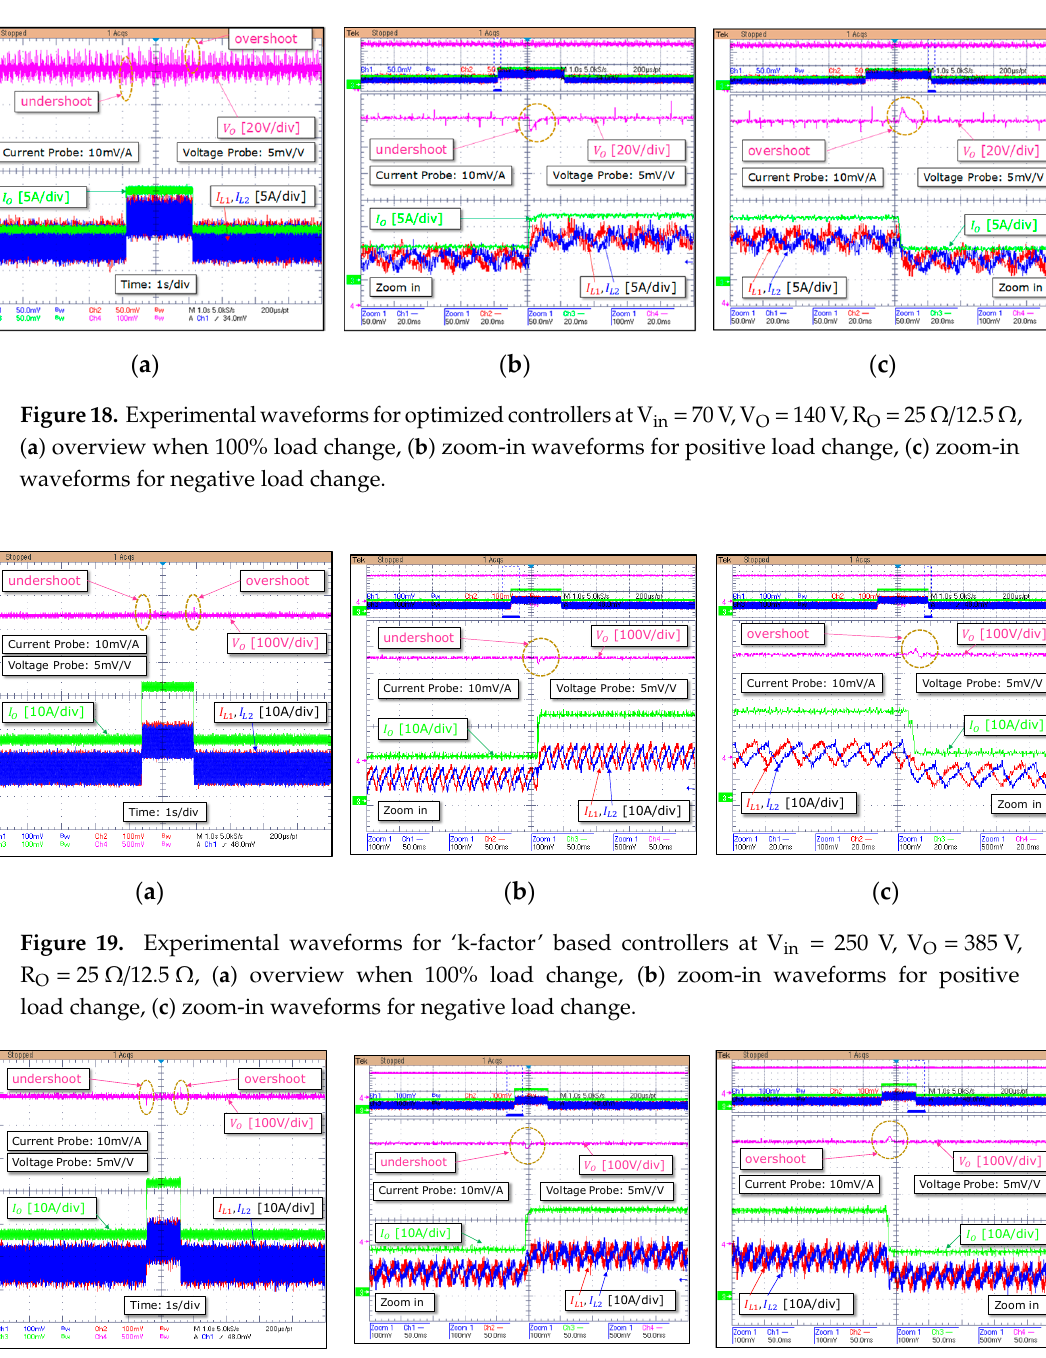
Figure 17. Experimental waveforms for ‘k-factor’ based controllers at V in = 70 V, V O = 140 V, R O = 25 Ω /12.5 Ω , ( a ) overview when 100% load change, ( b ) zoom-in waveforms for positive load change, ( c ) zoom-in waveforms for negative load change.